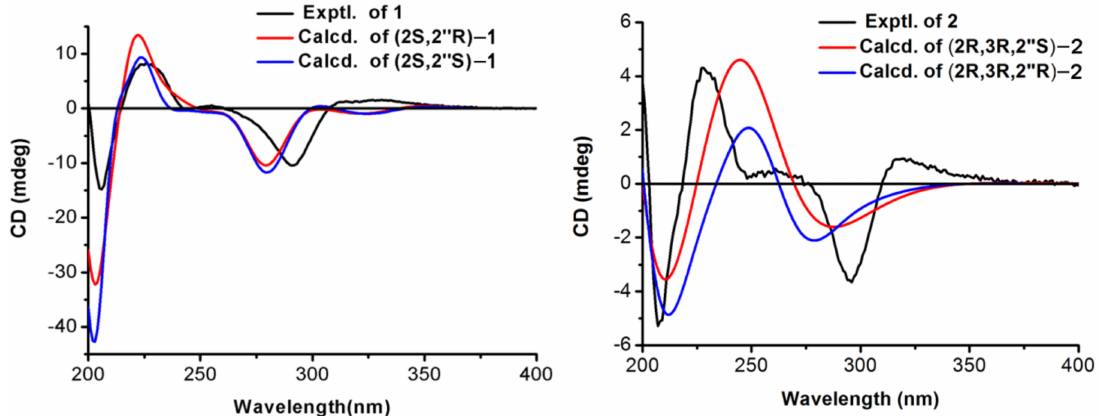
Figure 4. Experimental and calculated ECD spectra of compounds 1 and 2 .